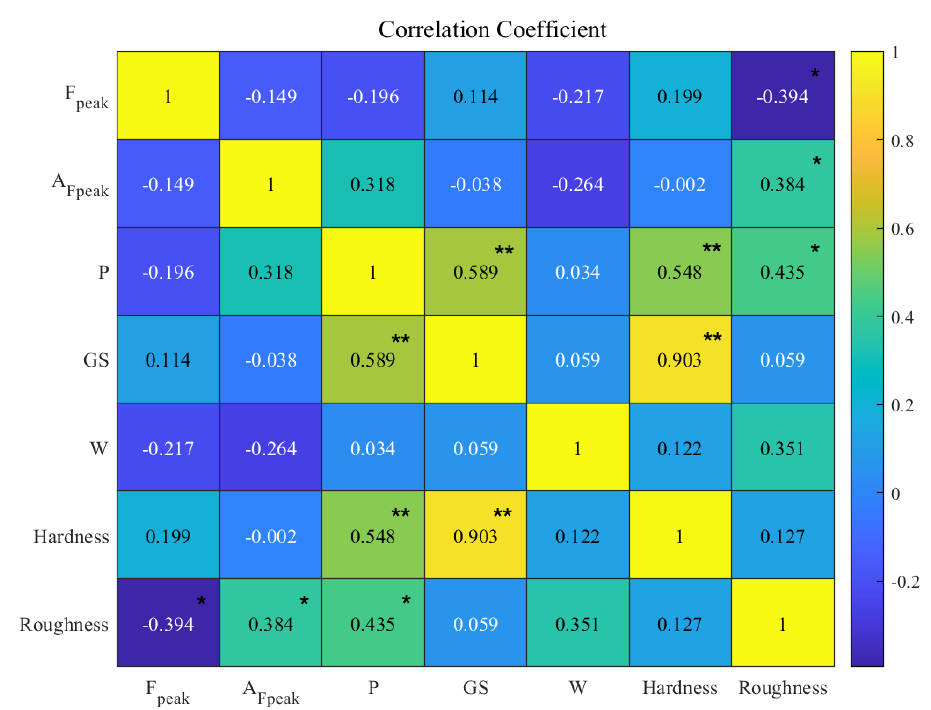
Figure 16. Correlation between features and hardness, roughness ( ∗∗ ≡ p ≤ 0.01, ∗ ≡ p ≤ 0.05 )